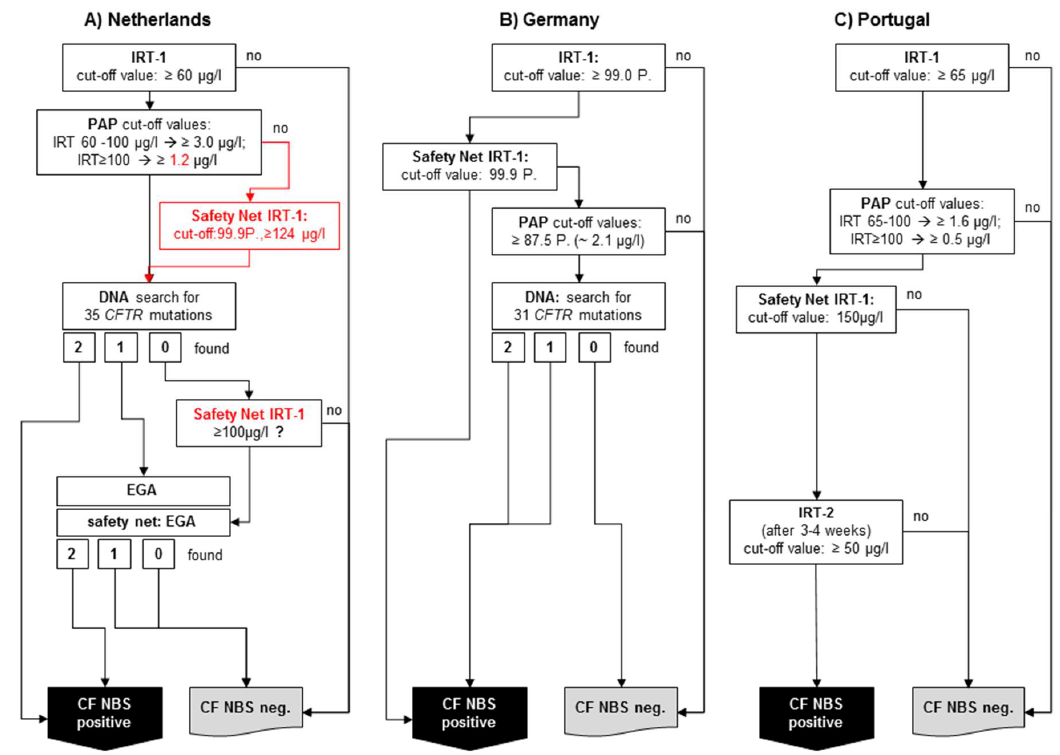
Figure 2. Simplified schemes of three selected PAP-based CF NBS protocols currently used: ( A ) The Netherlands: IRT / PAP / DNA(35) / EGA protocol including last modifications from 2016, ( B ) Germany: IRT / PAP-SN / DNA(31) protocol, ( C ) Portugal: IRT / PAP-SN / IRT protocol.